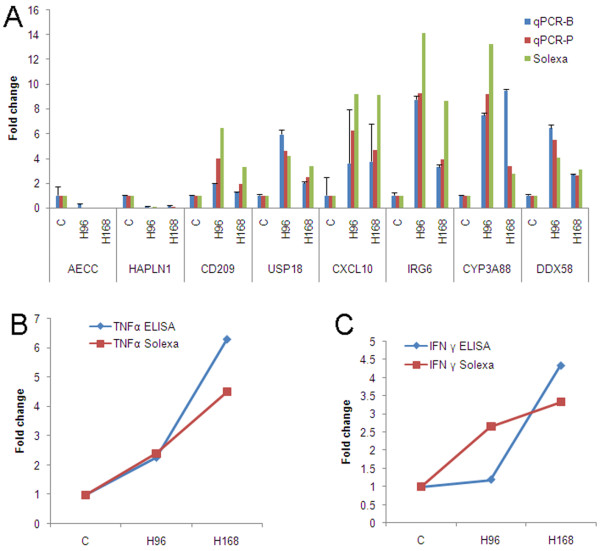
Validation of DGE data by qPCR and serum cytokine analysis. (A) qPCR validation of DGE data. Relative quantification was carried out to measure changes in target gene expression in lung samples relative to an endogenous reference sample. Results are expressed as the target/reference ratio of each sample normalized by the target/reference ratio of the calibrator; HPRT1 was used as a reference gene. The Y axis indicates the fold change of transcript abundance in H-PRRSV infected pigs compared to the C. For the C sample, the fold change of transcript abundance relative to the C sample equals one. qPCR-B: the RNA samples from independent extractions from biological replicates; qPCR-P: the RNA samples from pooled samples that were used for deep sequencing. Error bars represent SE. (B-C) the correlation between change in protein concentration from serum and transcript abundance from lungs. The levels of cytokines (TNFα and IFNγ) in serum were analyzed using ELISA. The levels at 96 and 168 hours were compared with the C to determine relative changes. The Y axis represents the relative fold change.